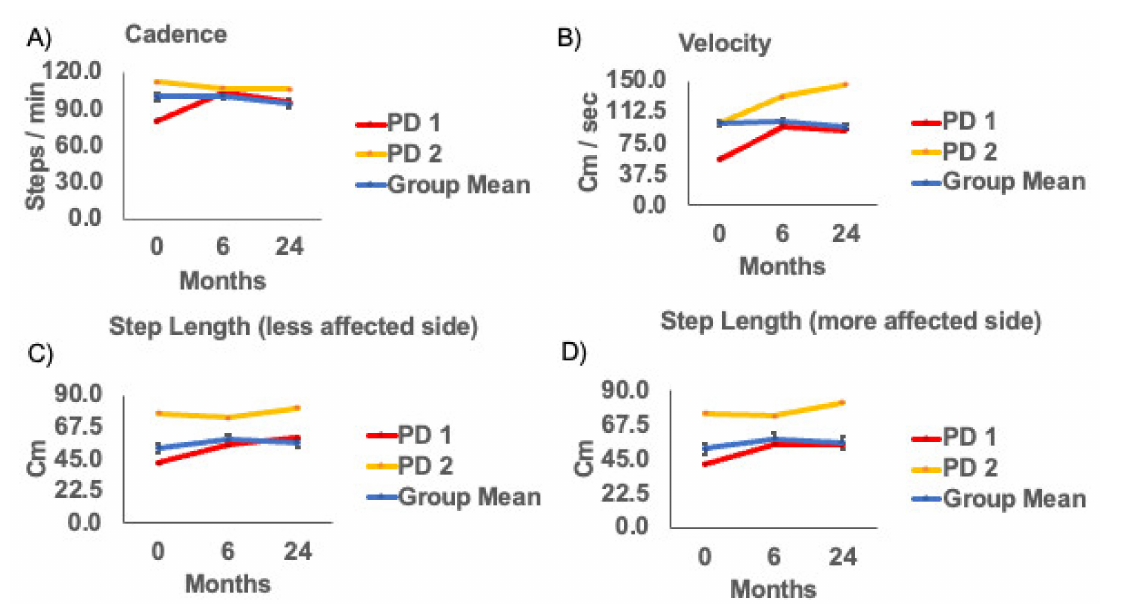
Figure 3. (A ) Cadence ( B ) Velocity ( C ) Step length (less) and ( D ) Step length (more) affected sides at baseline(0 month), 6 and 24 months post-surgery. Group means (SE), and example subjects: Parkinson’s disease (PD) subject 1 (UPDRS = 54), and PD subject 2 (UPDRS =